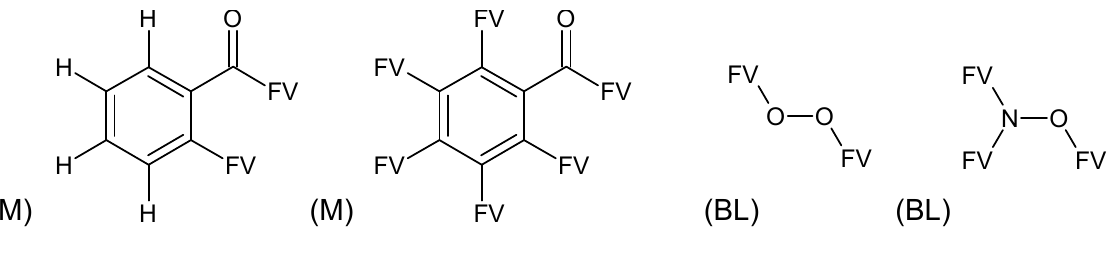
Figure 1. Substructures for Challenge 10. Letters to the bottom left indicate (M) macroatom; (BL) bad list (forbidden) structures. FV = free valence.